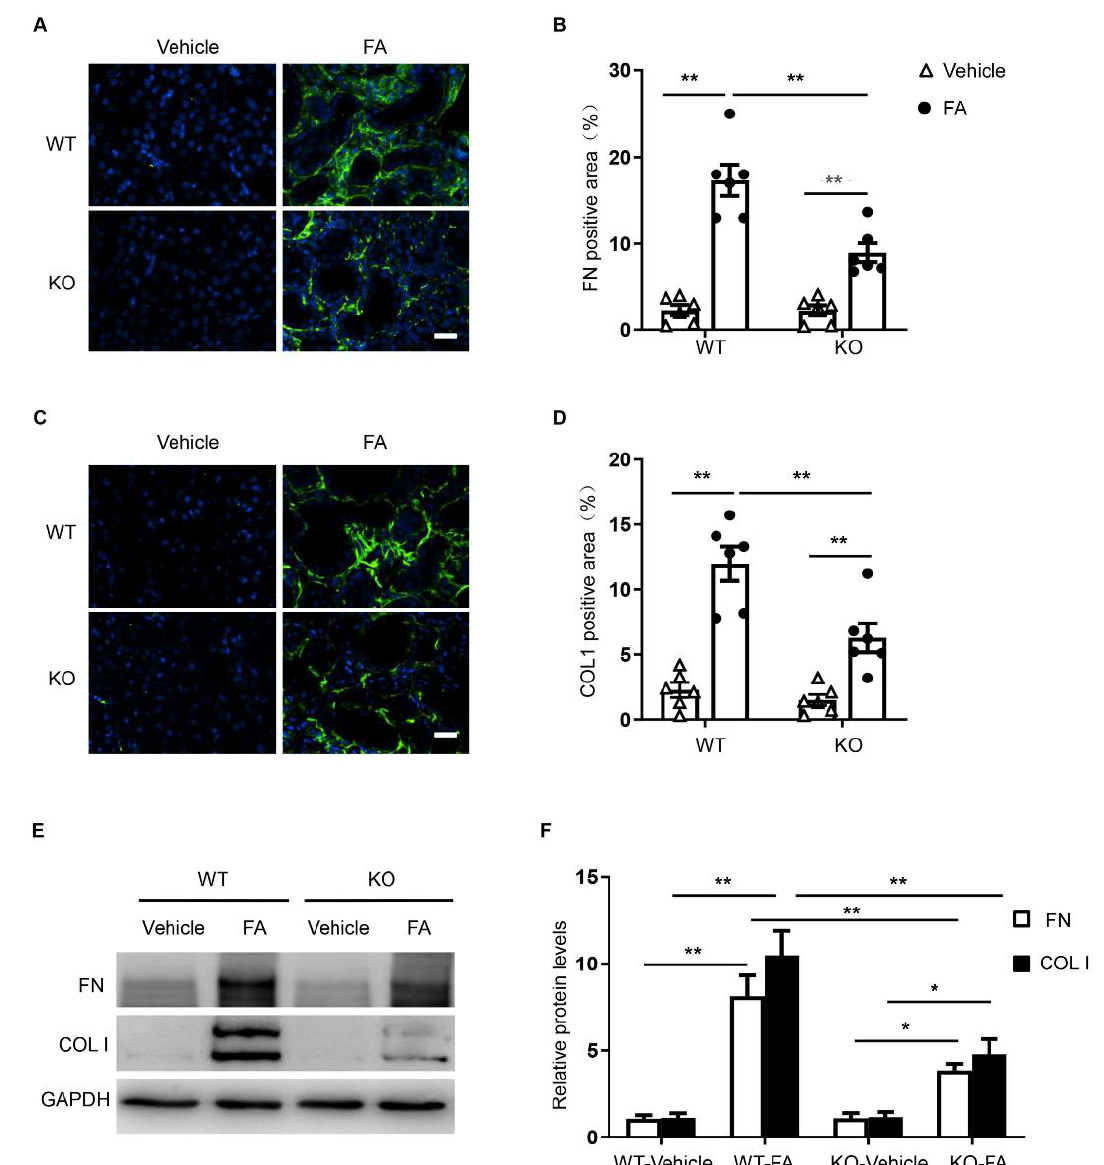
Figure 5. STAT6 deficiency attenuates the expression of ECM proteins in folic acid nephropathy. ( A ) Representative photomicrographs of kidney sections immunostained for fibronectin (green) and counterstained with DAPI (blue). Scale bar, 50 µ m. ( B ) Quantitative analysis of the fibronectin-positive area in kidneys. ** p < 0.01. n = 6 per group. ( C ) Representative photomicrographs of kidney sections immunostained for collagen I (green) and counterstained with DAPI (blue). Scale bar, 50 µ m. ( D ) Quantitative analysis of collagen-positive area in kidneys. ** p < 0.01. n = 6 per group. ( E ) Representative Western blots show protein expression of collagen I and fibronectin in the kidneys. ( F ) Quantitative analysis of protein levels of collagen I and fibronectin in the kidneys. ** p < 0.01; * p < 0.05. n = 6 per group.